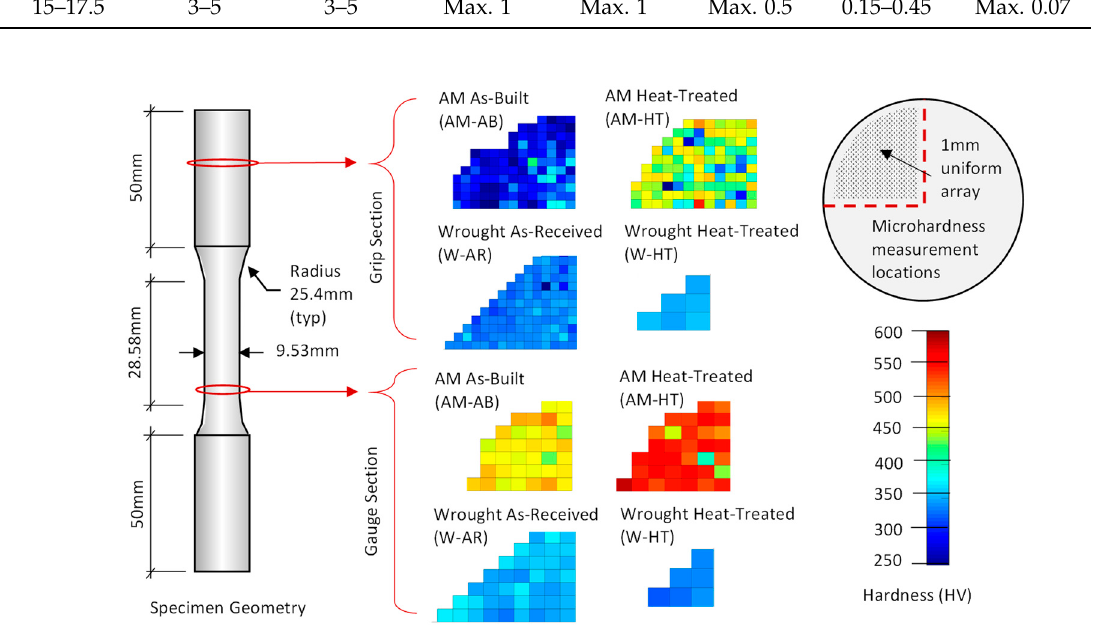
Figure 2. Specimen dimensions and micro-hardness test measurements from gauge and grip loca- tions.